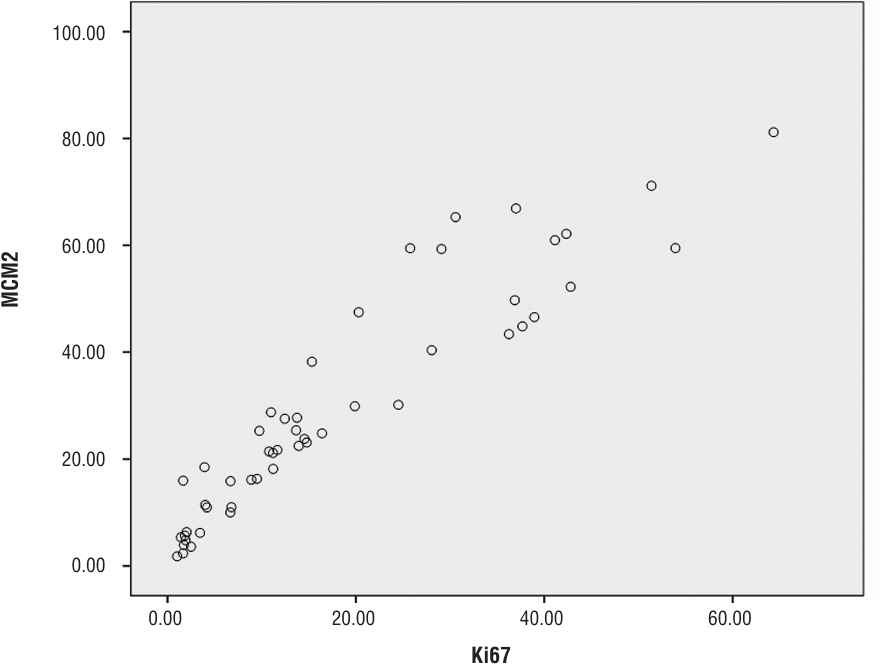
figure 3 - scatter diagram showing correlation of expression between Ki-67 and McM-2. note that smaller increases in Ki-67 result in larger increases of